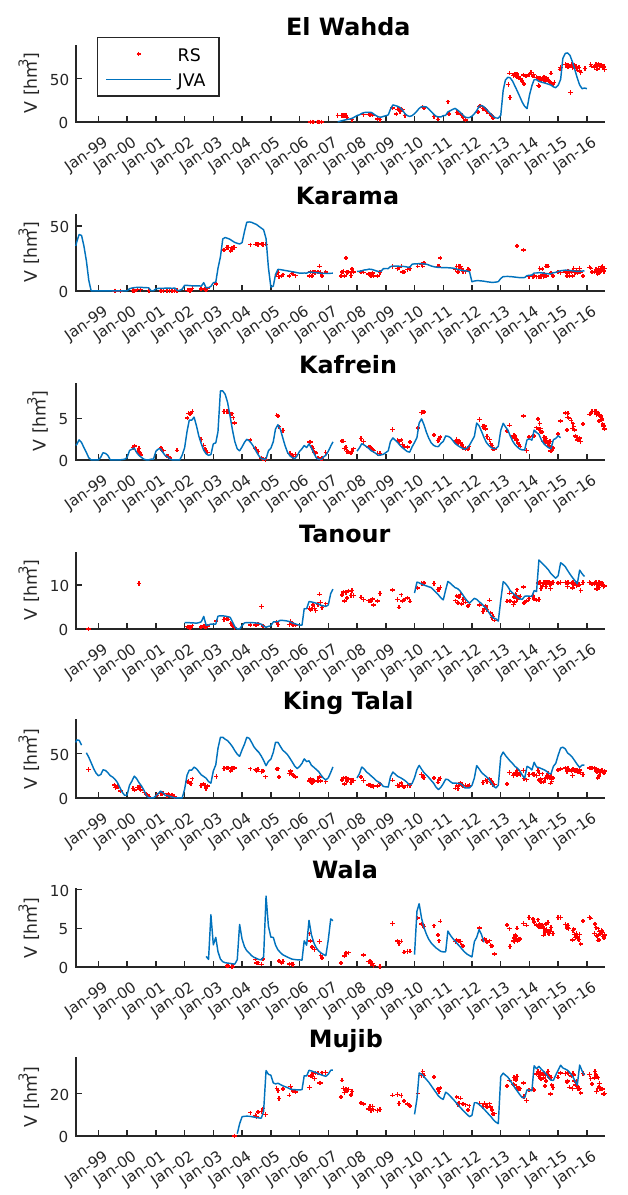
Figure 11. Storage variations for Jordan managed reservoirs. Red crosses indicate estimates from the method developed in this paper. The blue lines indicate in situ data records that were made by the Jordan Valley Authority (JVA).